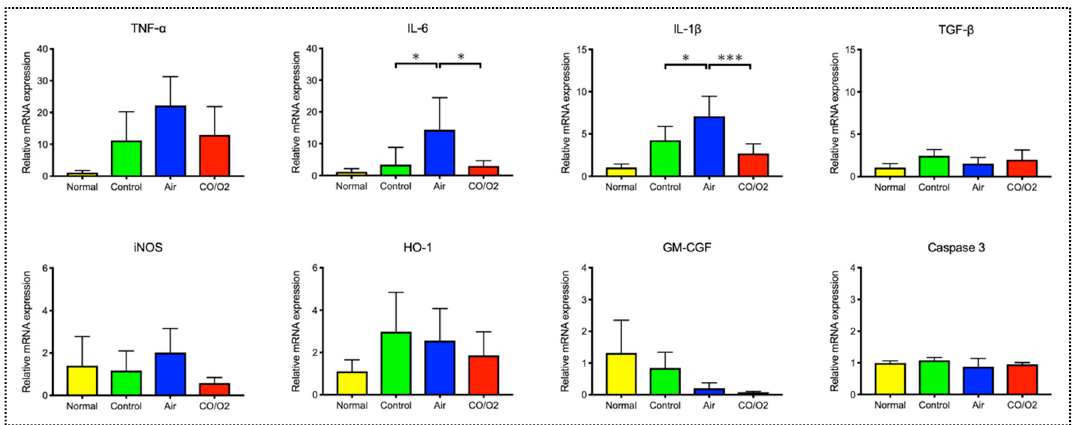
Figure 3. Changes in relative mRNA expression levels of mediators in donor rat lungs after 90 min of reperfusion. Each data of bars are expressed as the means ± standard deviations. *** p < 0.001, * p <